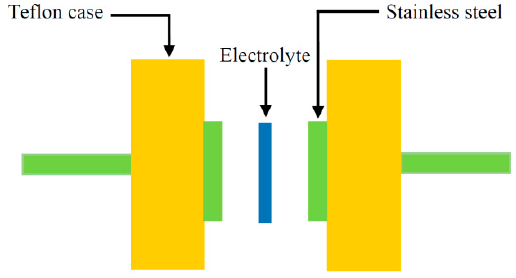
Figure 6. Schematic diagram for TNM and LSV measurements.